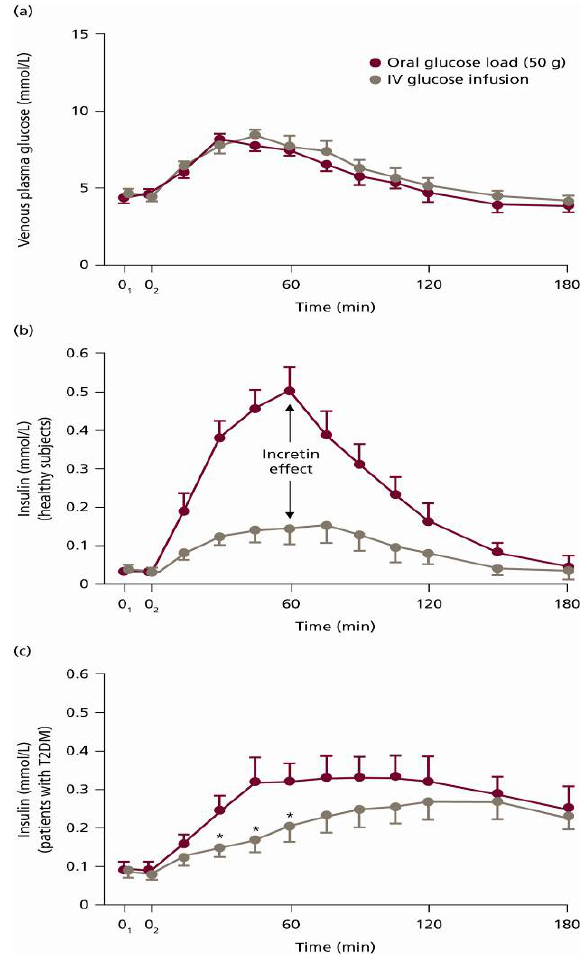
Figure 3. (a) Plasma Glucose and Venous Insulin Response in the Plasma; (b) Normal Insulin Response to Oral/Intravenous Glucose Load; (c) This Response in People with Type 2 Diabetes [7]. Reprinted with permission from Springer, ©